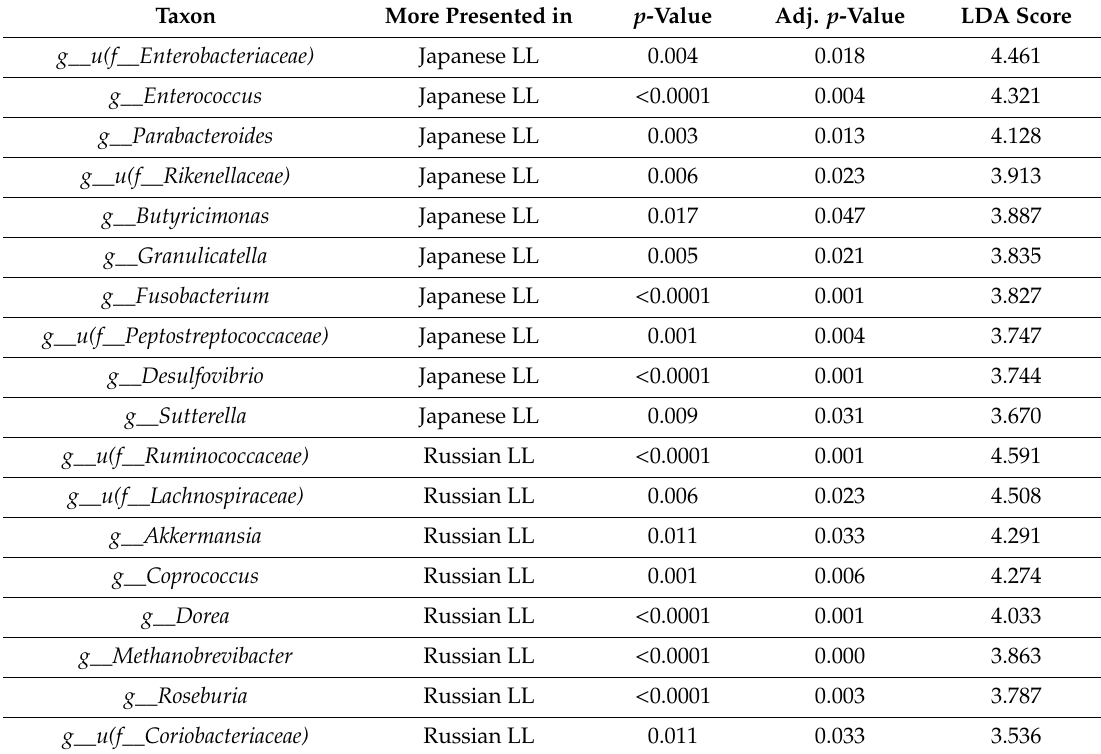
Table 2. Di ff erences in the microbiota composition between the LL from Japan and Russia at the genus level (Wilcoxon rank-sum